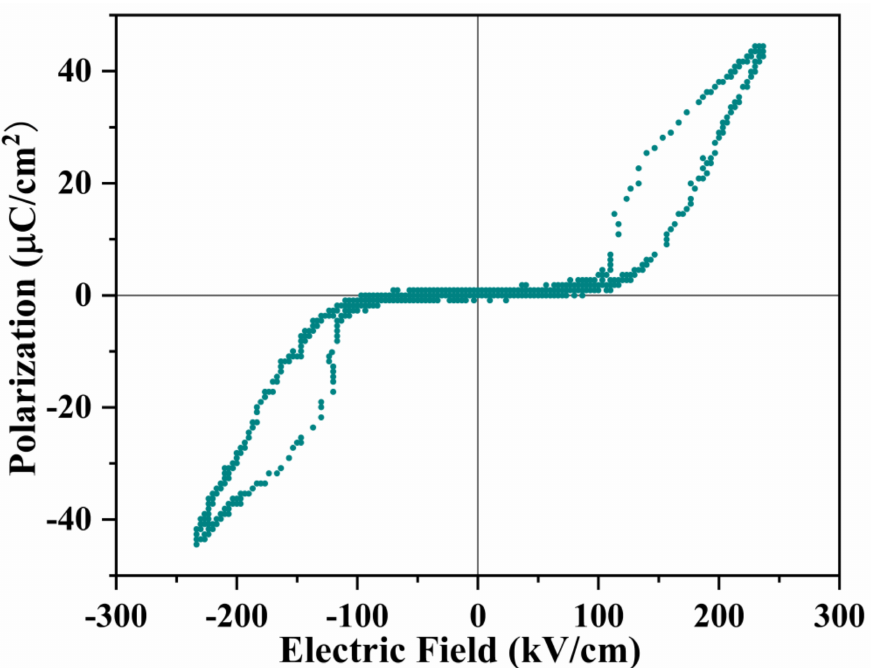
Figure 5. Fully saturated double P-E hysteresis loops as the experimental evidence for the antiferro- electrics of the La 0.5 Sr 0.5 Fe 12 O 19